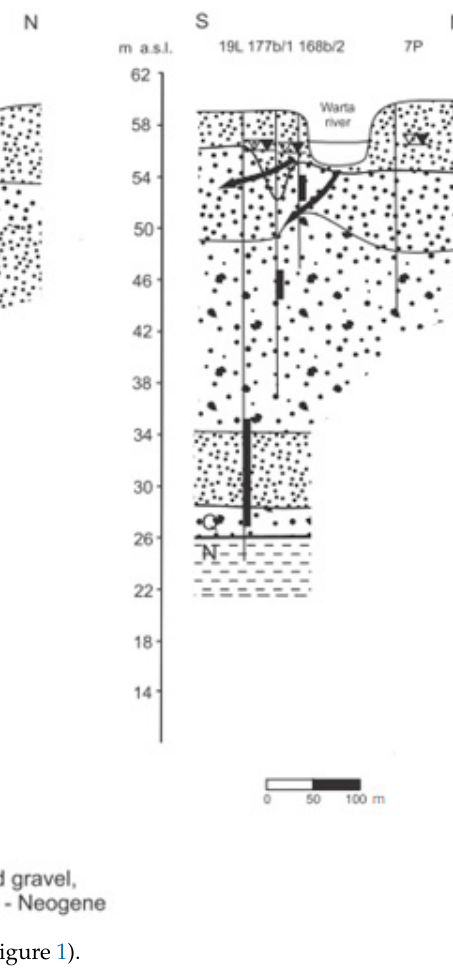
Figure 2. Hydrogeological cross-sections (lines of cross-sections are marked in Figure 1)